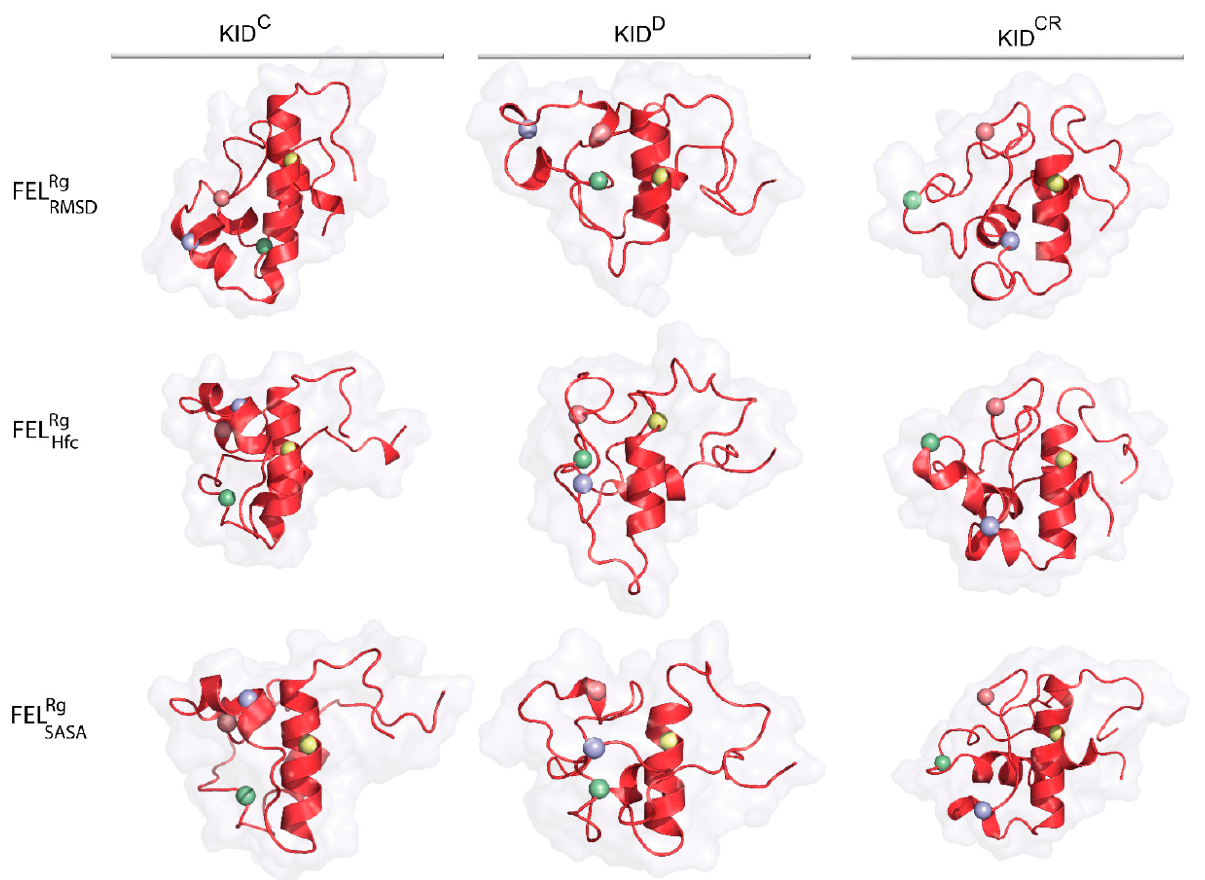
Figure 7. Representative conformations of the deepest well on the free energy landscape (FEL) of KID. KID displayed as red ribbons contoured with a surface-filled model. Position of the tyrosine residues (C α -atoms) is shown as balls coloured in yellow, blue, red and green for Y703, Y721, Y730 and Y747, respectively.